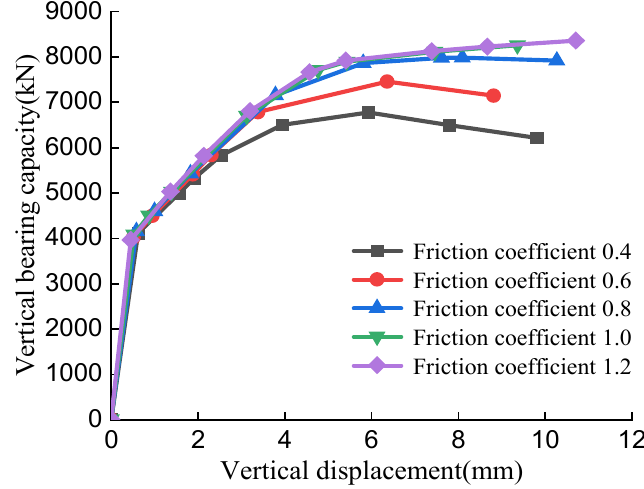
Figure 21. Comparison of different friction coefficients.